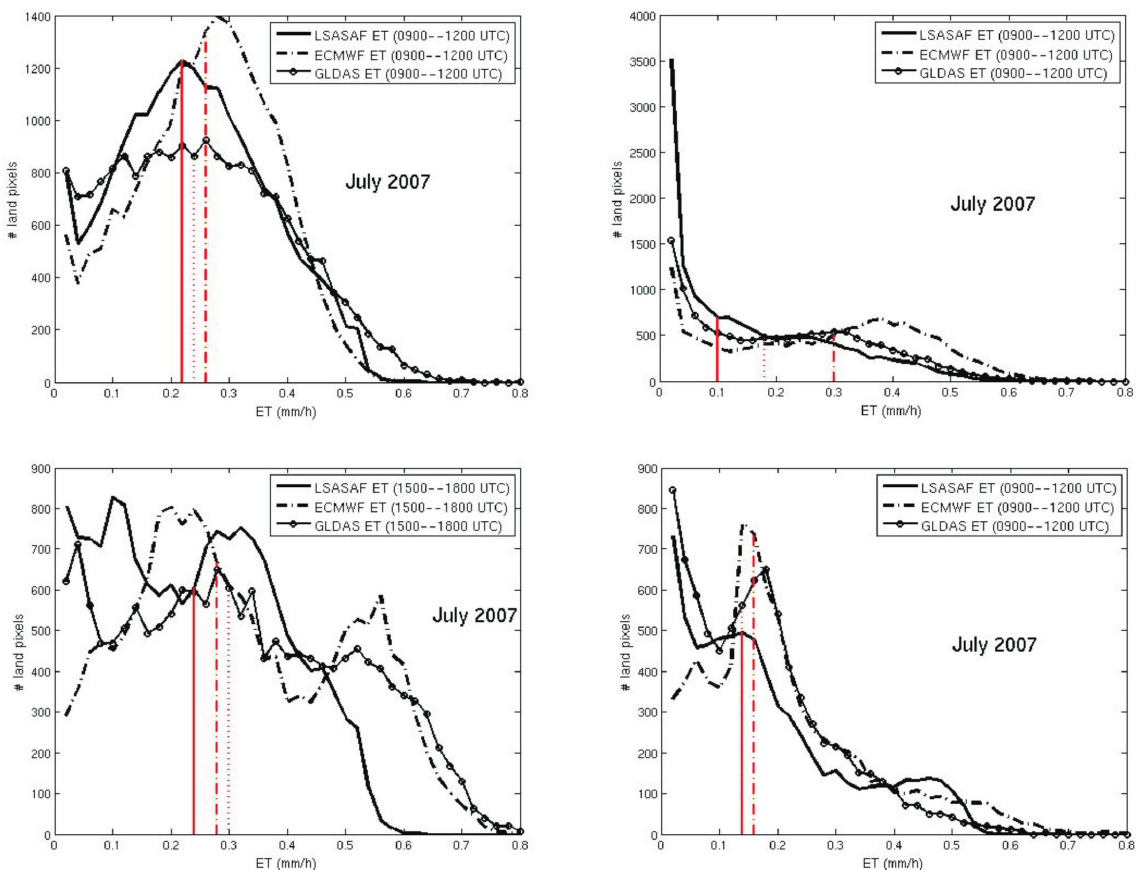
Fig. 6. Distributions of ET estimates from LSA-SAF (solid line), ECMWF (dash-dotted line) and GLDAS (solid line and circles). Each figure encompasses the mean distribution of the 3 hourly averaged ET (09:00 to 12:00 UTC) for July 2007, as well as the mean values of the distributions (vertical lines). Europe (upper left), North of Africa (upper right), South of America (lower left), South of Africa (lower right).